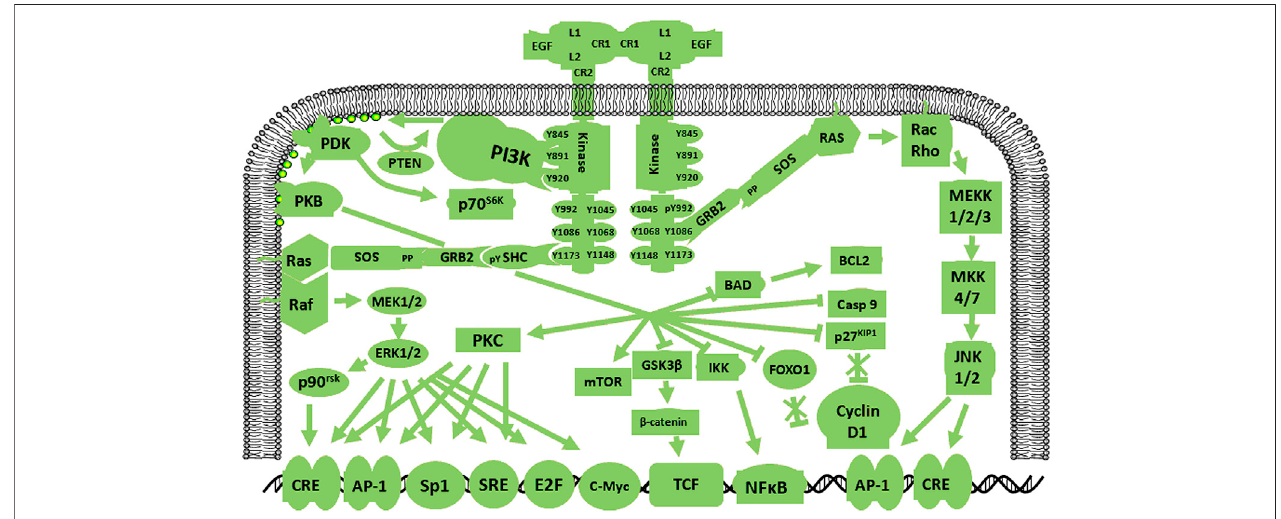
FIGURE2| SchematicdiagramoftheHER2signalingpathway.HER2ampli fi cationinhumanGBMislimitedbythe EGFR gene,indicatingthatHER2expressionin GBM is closely related to the EGFR. HER2 pathway activation gives rise to cascades of speci fi c signals.